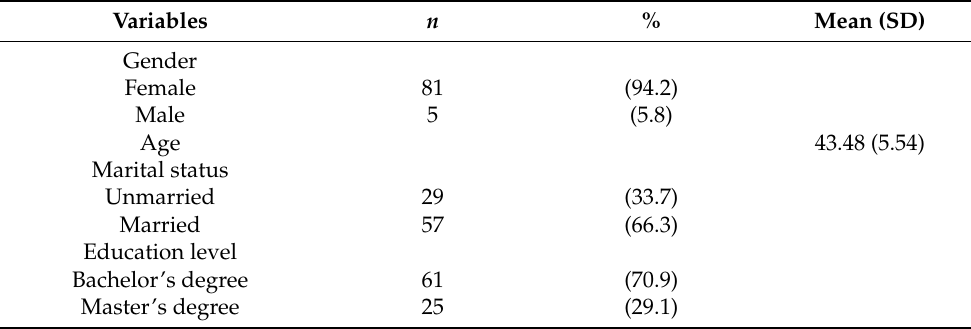
Table 1. Demographic characteristics of the